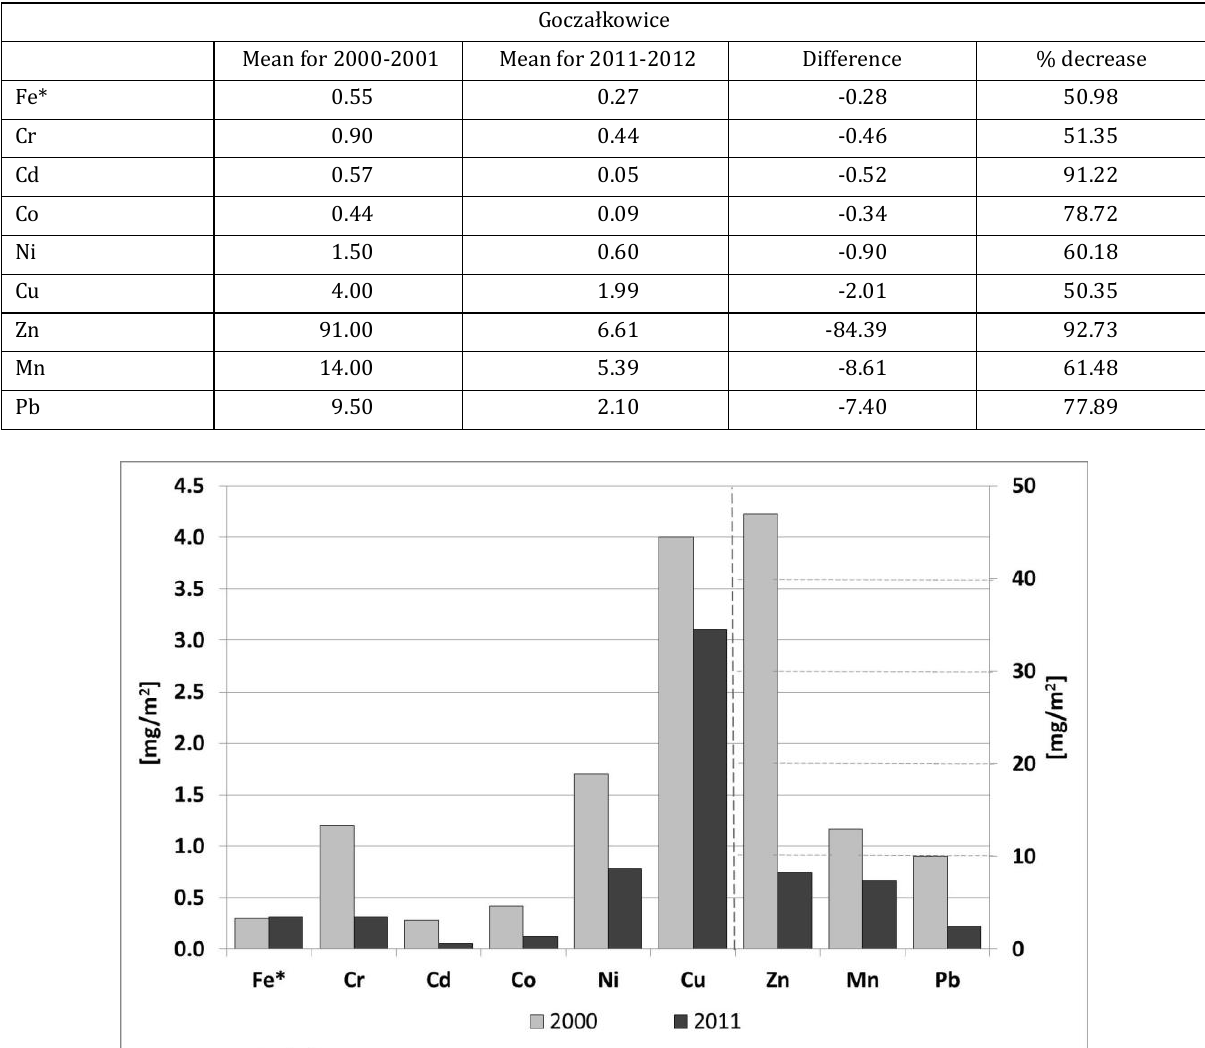
Table 6. Mean values of dry deposition in Goczałkowice in 2000- 2001, 2001-2012. [mg/m 2 ], Fe* – [g/m 2 ]